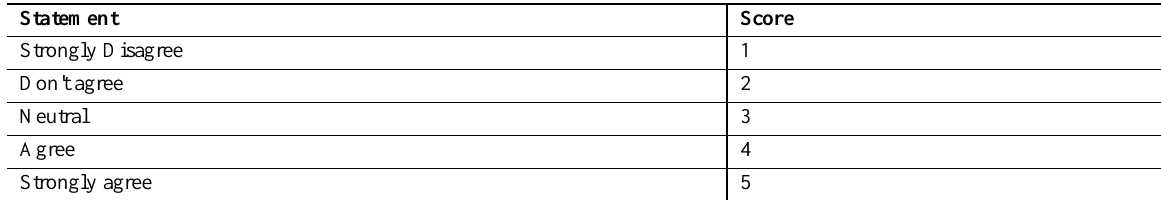
Table 1: Research instrument answer